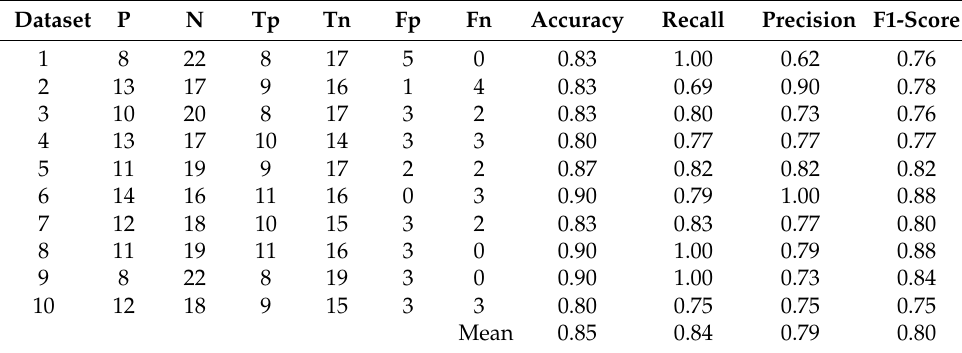
Table 2. MLPC models were trained and tested on ten randomly selected